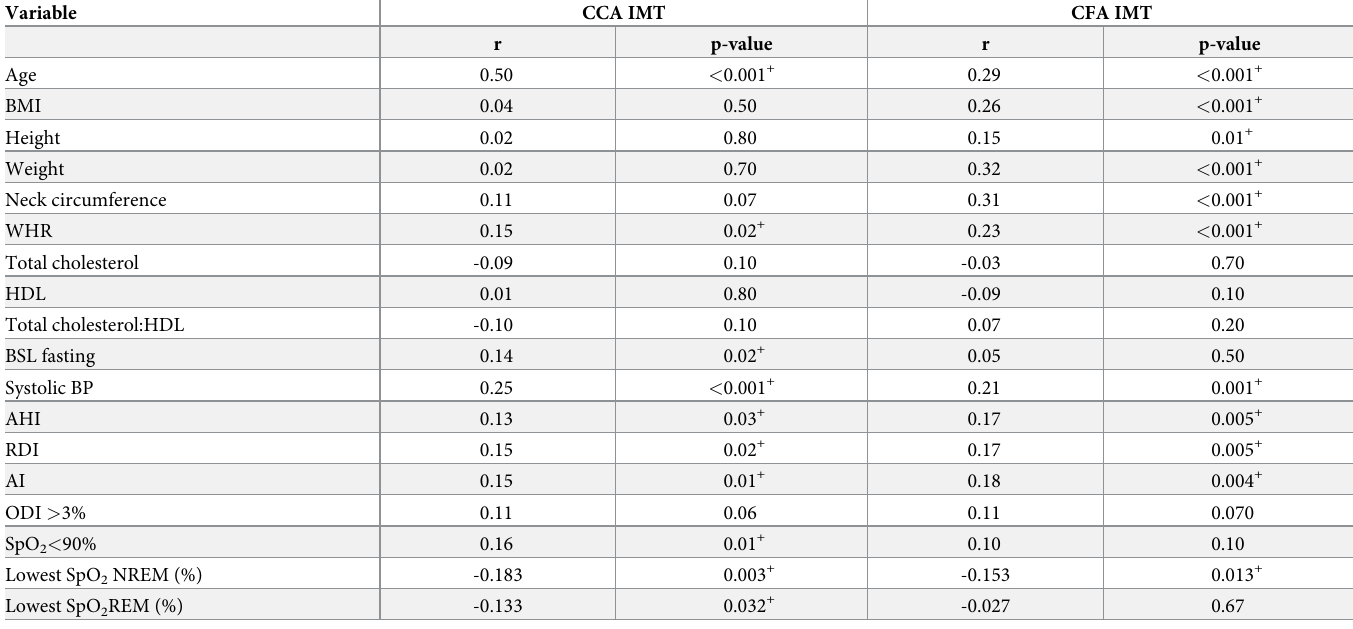
Table 3. Main group—Spearman rank correlations. Spearman rank correlation (r) between each variable used in the models and IMT values for CCA and CFA. See text for abbreviations.